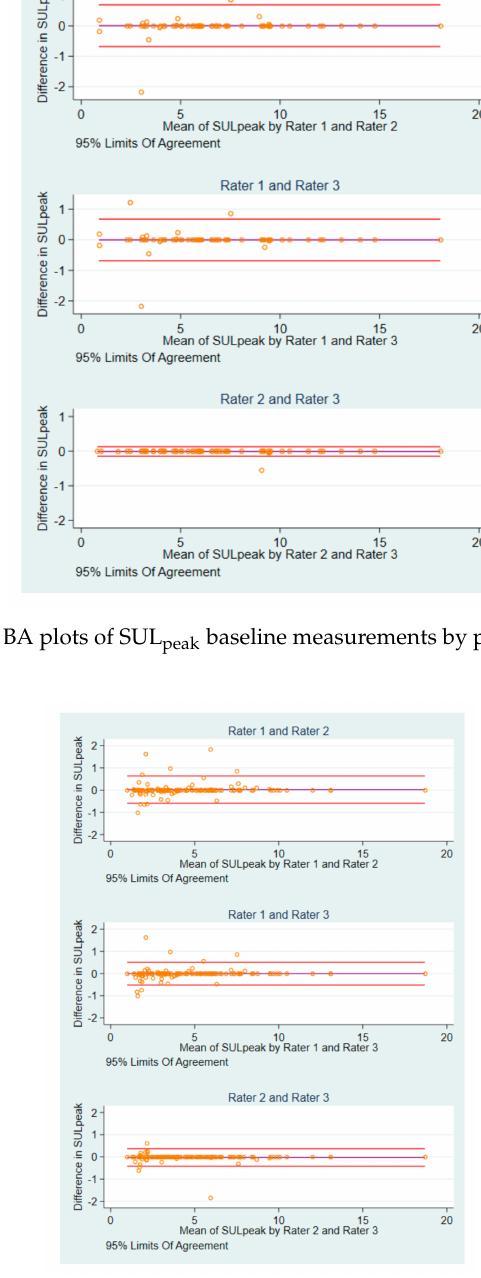
Figure 3. Bland-Altman plots of post-baseline SUL peak measurements by pairs of